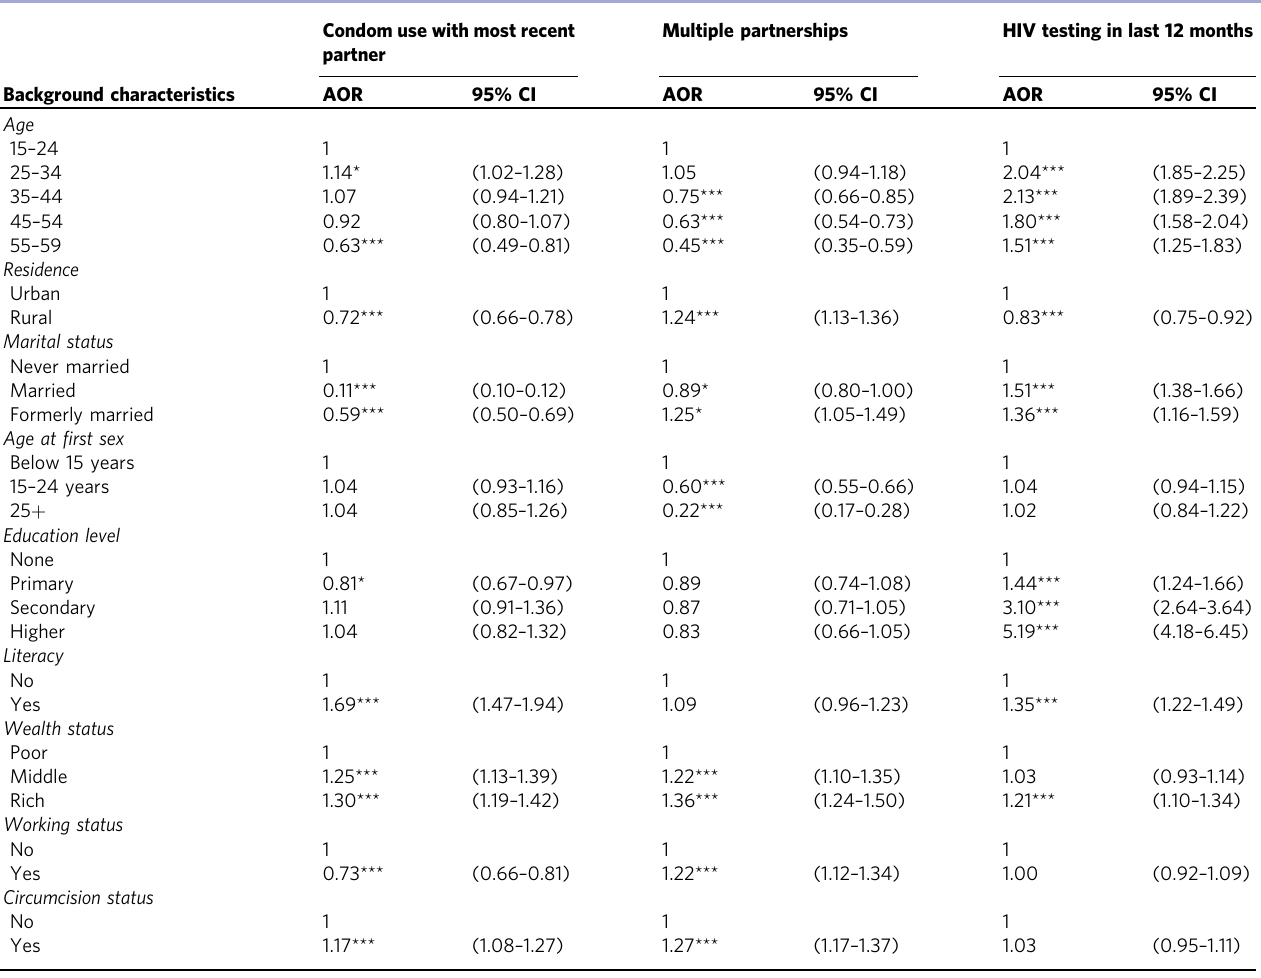
Table 4 Results of pooled multivariate analyses examining the effect of individual-level factors on HIV risk behaviours among men in Southern